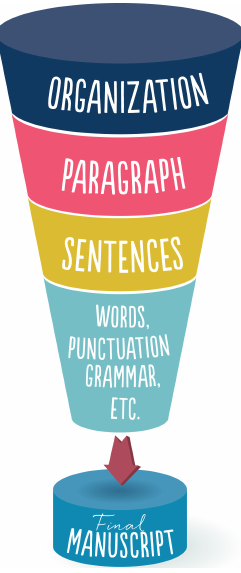
Figure 2. The writing/editing funnel model used to guide feed- back discussions in the ClimateSnack writing groups, based on Schultz (2013) and Snellman